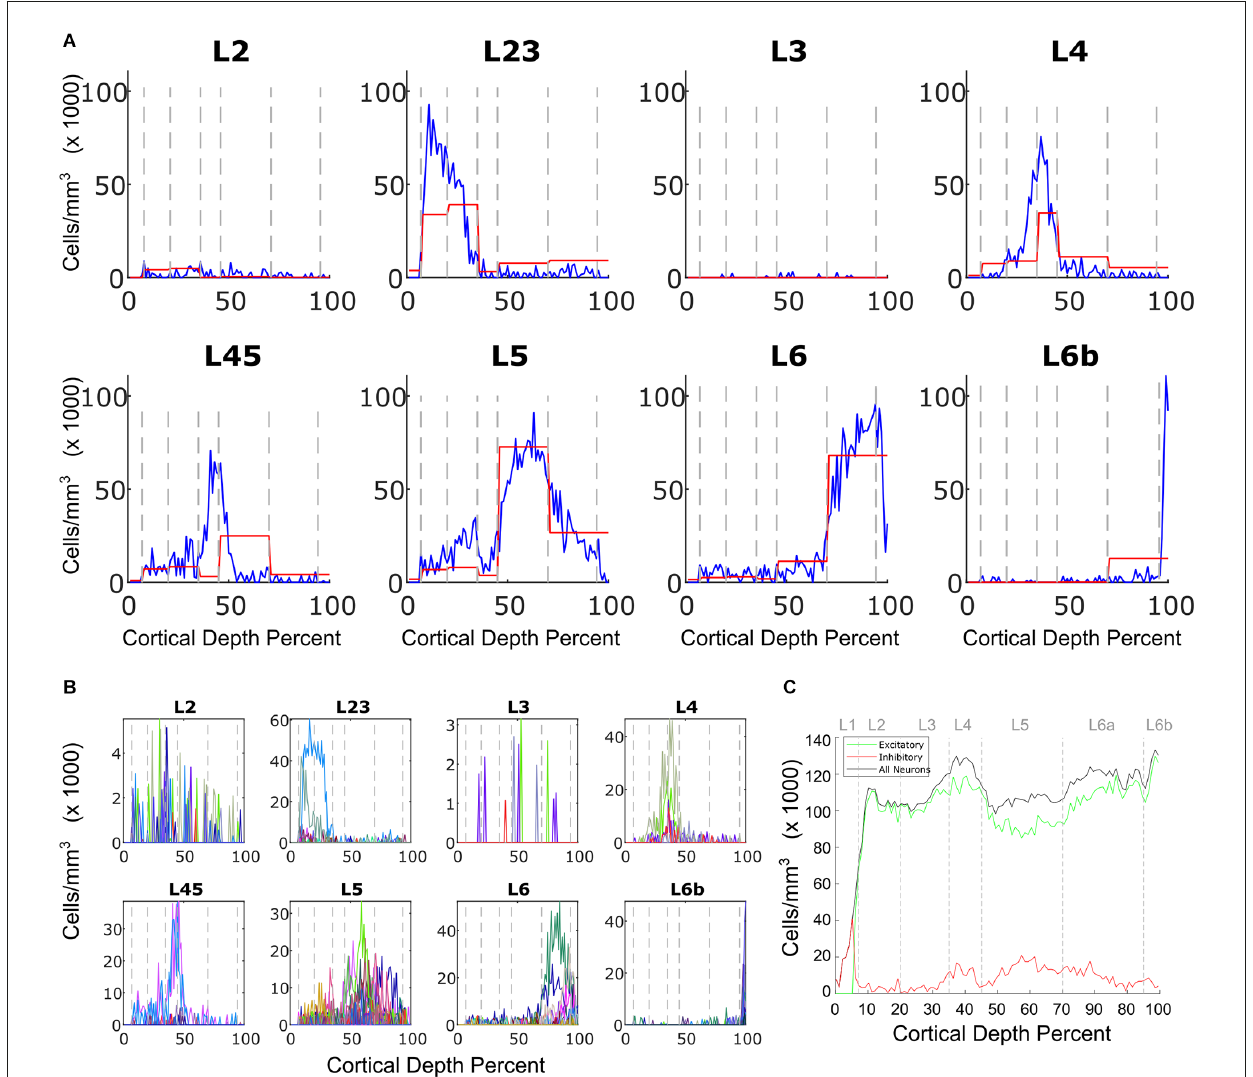
FIGURE3 Excitatory neuron predictions. (A) Predicted cell densities for broad classes of excitatory cell types. On the x axis, 0 denotes the top of layer 1 while 100 is the bottom of layer 6. Cell density units are cells/mm 3 . Cell types for the most part are present where the transcriptome cell-type labels suggest they should be. The red line indicates the distribution of samples in the AIBS data. (B) A breakdown distribution of the subtypes whose sum is shown in (A) . Each color represents a different transcriptomic type. Since L2 and L3 cells were present at very low levels, there is much noise in their predicted distributions. (C) Excitatory (green) and inhibitory (red) profiles are shown, and total neurons (black). The inhibitory cell density reaches a peak in the superficial layers. In all graphs, layer boundaries for L1, L2, L3, L4, L5, L6a, and L6b are indicated by the dashed gray lines and placed at 8, 20, 35, 45, 70, 95, and 100 percent of cortical thickness,